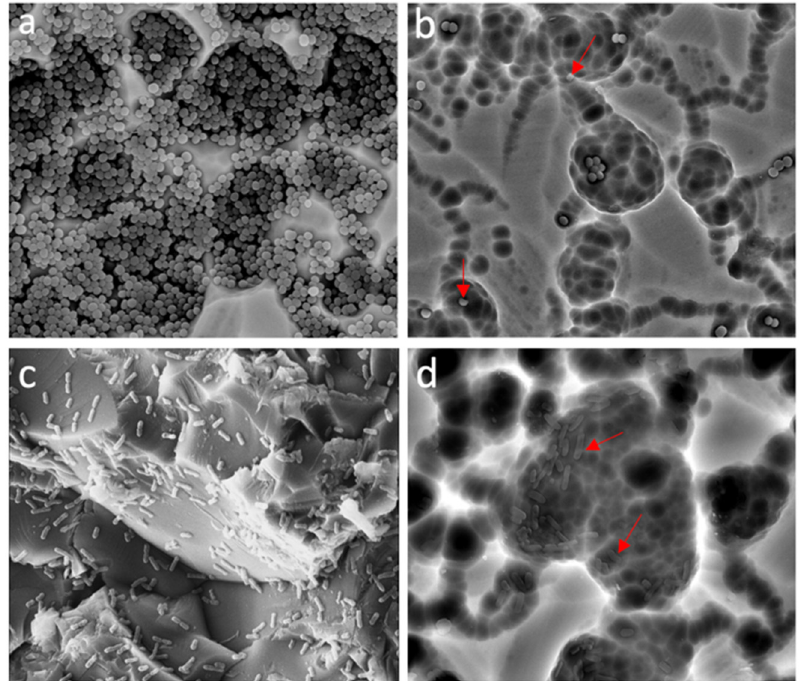
Figure 3. SEM micrographs showing the effect of the LTC II EO on the morphology and structure of the biofilm after 24 h of culture: ( a ) Untreated S. aureus ATCC 29213; ( b ) S. aureus biofilm treated with LTC II EO; ( c ) Untreated E. coli ATCC 25922; and ( d ) E. coli ATCC 25922 treated with LTC II EO. Micrographs are presented at 8000× magnification. Red arrows indicate cell membrane shrinkage, deformed cells, and seriously damaged cells.